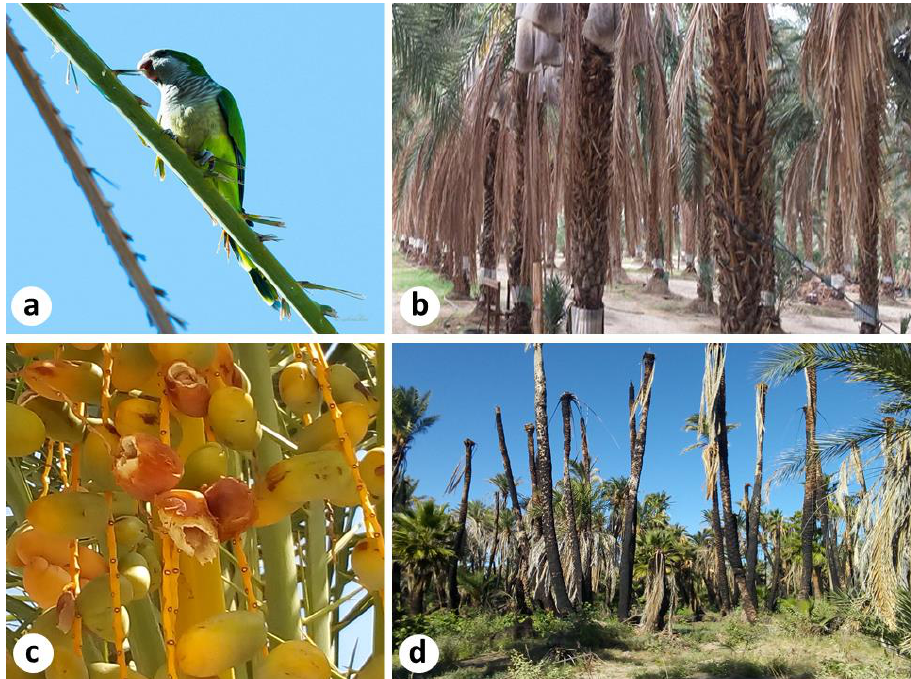
Figure 3. Current agricultural problems. ( a ) Monk parakeet devouring a date palm branch in Hermosillo, Sonora. ( b ) Sheet cover at the base of the trunk of the palm, to prevent the climbing of small rodents, in Laguna Salada, Baja California. ( c ) Bird damage to date fruit. ( d ) Remains of burned palm trees by natural fire in the oases of San Ignacio, Baja California Sur.